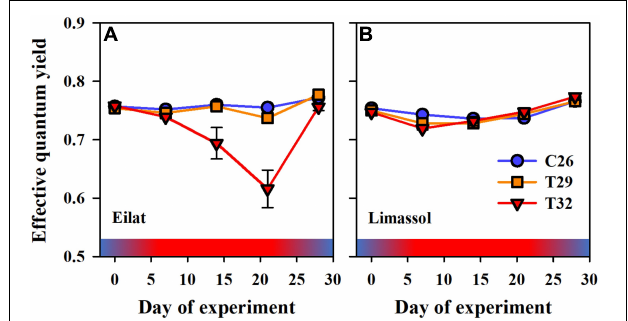
FIGURE 6 | Effects of a simulated heat wave on plant photosynthetic functionality of native (A) vs. invasive (B) populations of H. stipulacea . Shown are changes over time (days of experiment) in the effective quantum yield (cid:49) F/F (cid:48) m . In all parameters, results represent n = 5, mean ± SE. Gradient color bars indicate the experimental heat